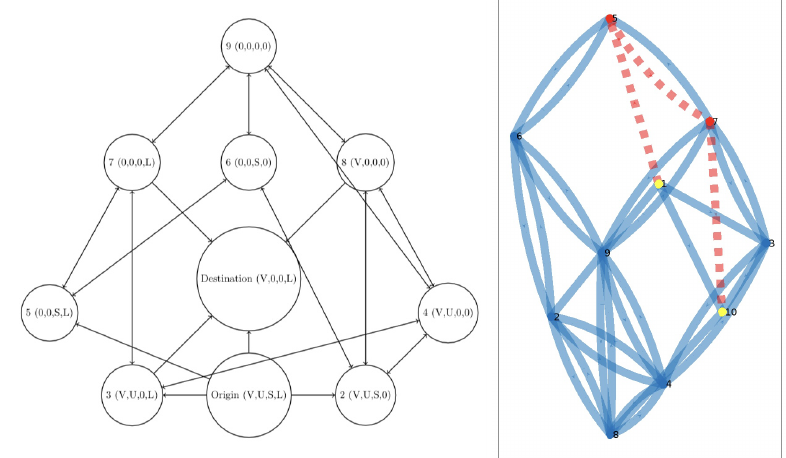
Figure 9. ( Left ): the graph of the ecosystem’s equilibria of [32]. ( Right ): the optimal path (1,5,7,10).